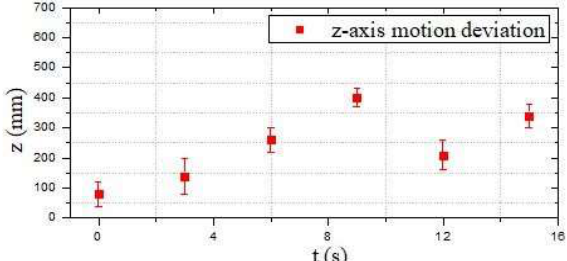
Figure 15. Experimental bypass obstacles.